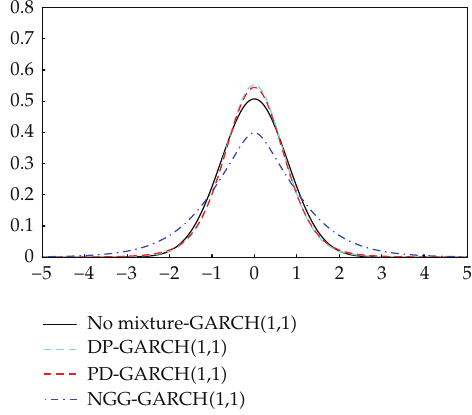
Figure 2: Predictive density